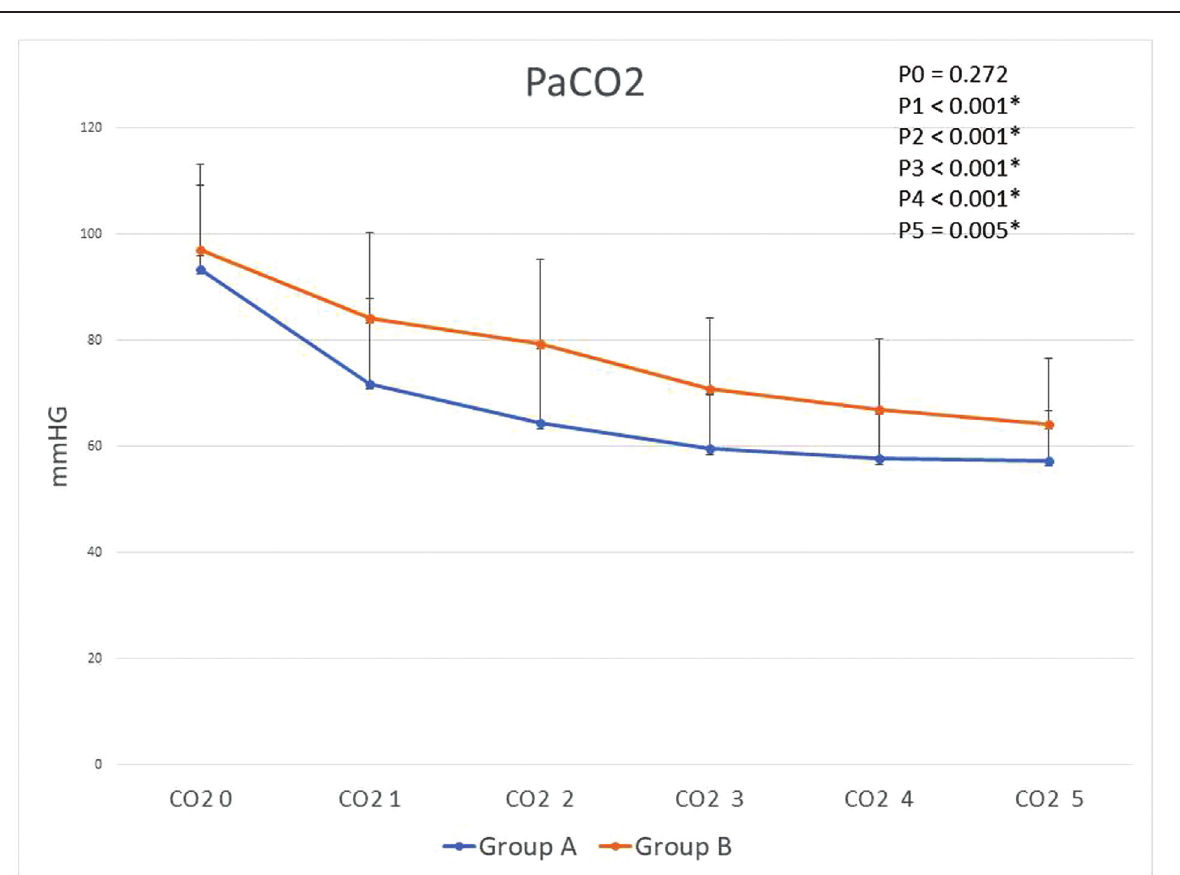
Effect of sedation on CO 2 . Data are expressed as mean±SD. Group A: sedation group, group B: no-sedation group. P value less than 0.05 is considered statistically significant.